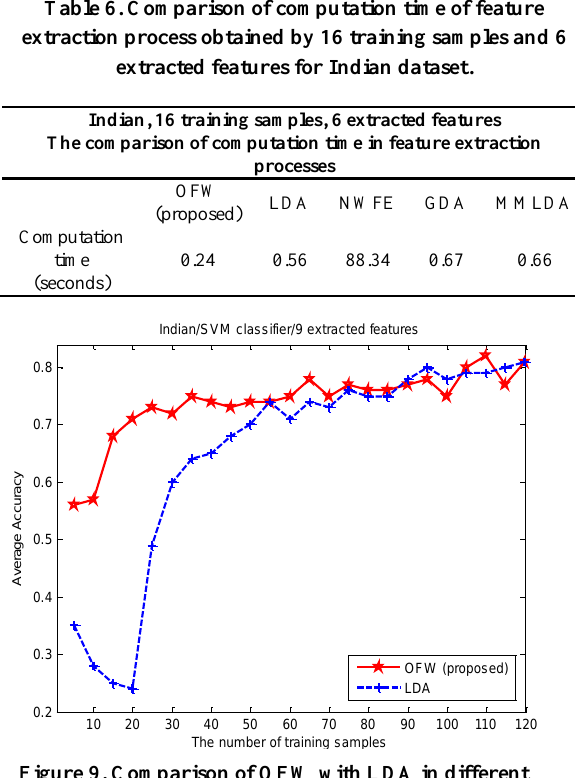
Figure 9. Comparison of OFW with LDA in different training sample size for Indian dataset obtained by SVM classifier and 9 extracted